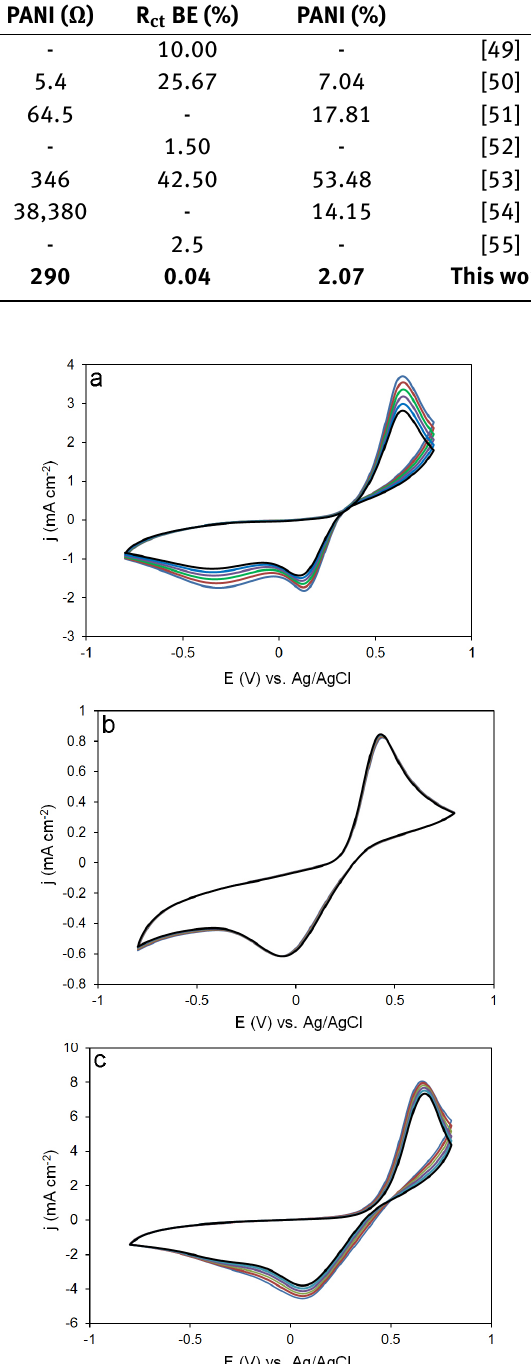
Figure 6: Cyclic voltammograms with 6 cycle for A: PANI, B: MeGO and C: MeGO/PANI on the FTO surface in 5 mM K 3 Fe(CN) 6 and 0.01 M